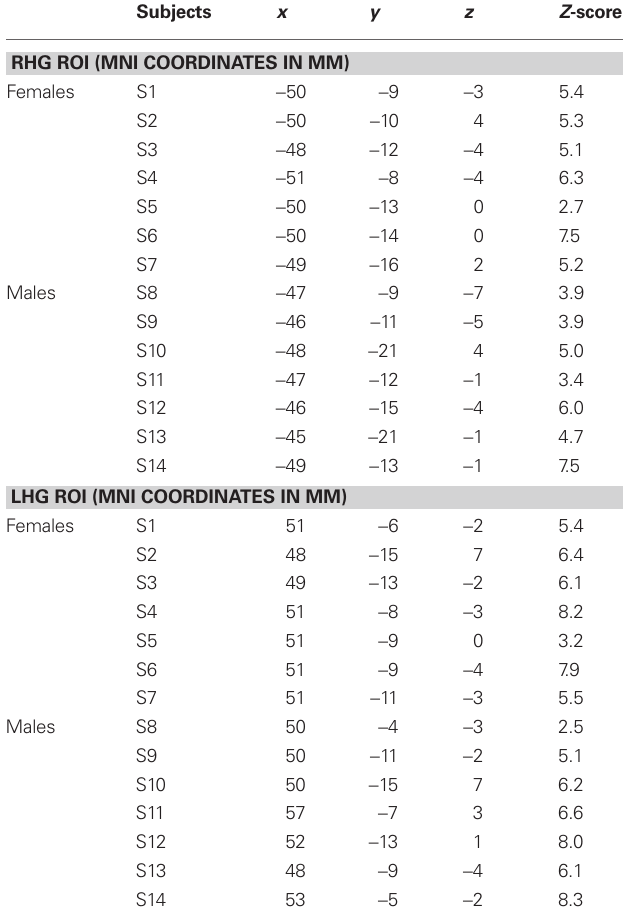
Table 1 | individual coordinates (mm) for the location of the targets for the left Hg Cog (lHg rOi) and for the right Hg Cog (rHg rOi) in MNi152 space and respective z -score values and percentage of BOLD signal- change (%BSC) within the 5-mm Hg rOi.